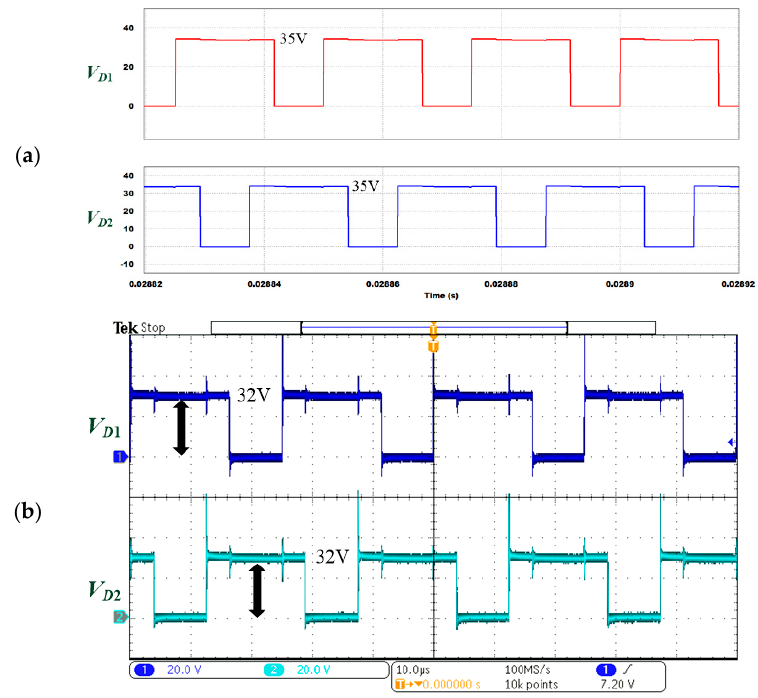
Figure 17. Waveforms of the proposed combined boost converter for the cross voltages across D 1 and D 2 . ( a ) Simulated waveforms; ( b ) Experimented waveforms.